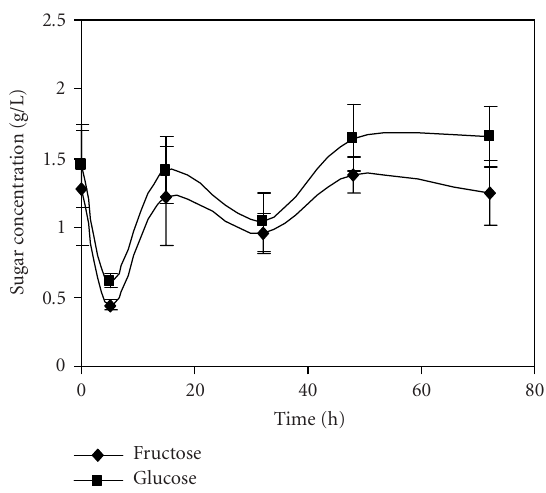
Figure 5. Evolution of sugar concentration in the pomegranate juice obtained by seed centrifugation and stored for 72 hours at 4 ◦ C. Bars represent standard deviation of 4 replications.